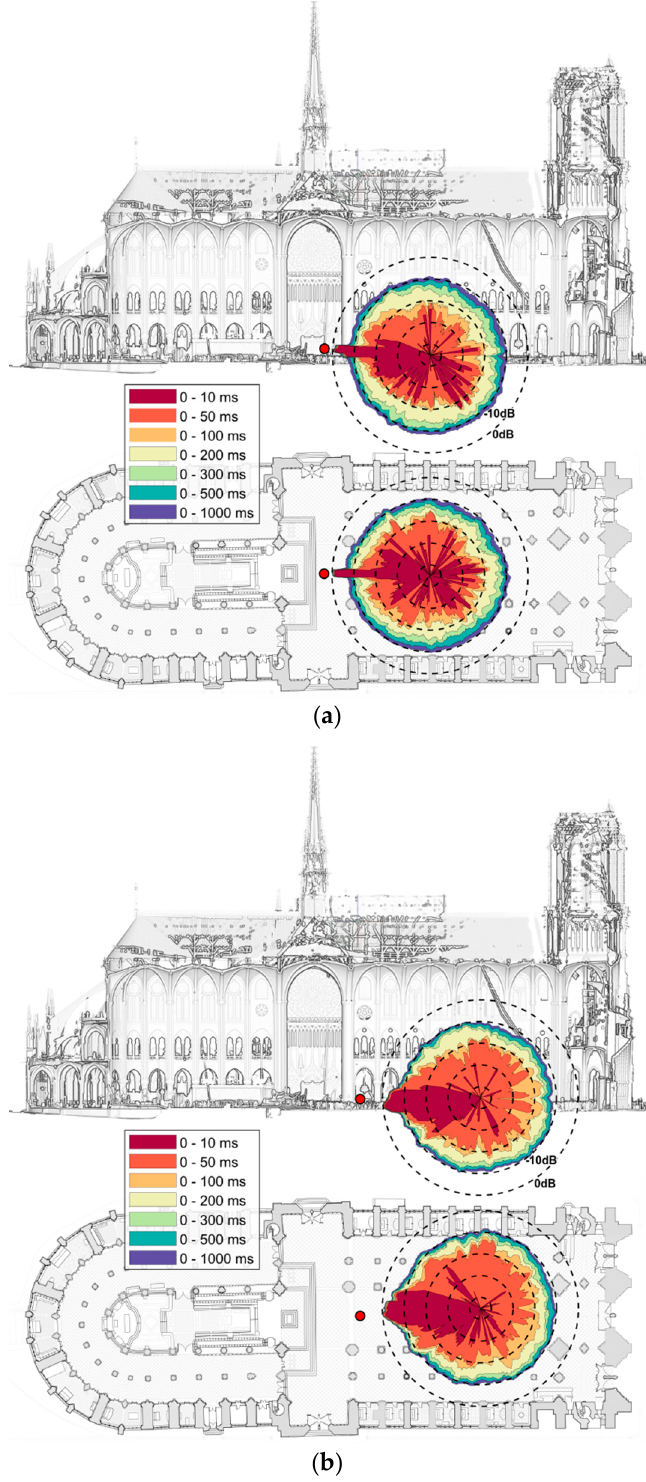
Figure 5. SDM analysis showing cumulative energy polar distribution curves from 0 ms to [10, 50, 100, 200, 300, 500, 1000] ms, band pass filtered 100 Hz to 5000 Hz, 5° sliding average. Source position indicated (red dot). ( a ) SDM analysis: state 2015, Src S2–Rec 1c; ( b ) SDM analysis: state 2020, Src S1, Rec 16. Longitudinal cross-sections obtained from the digital platform of the CNRS/MC scientific action for the restoration of Notre-Dame de Paris, source: 3D laser-scanning by Andrew Tallon (2016).